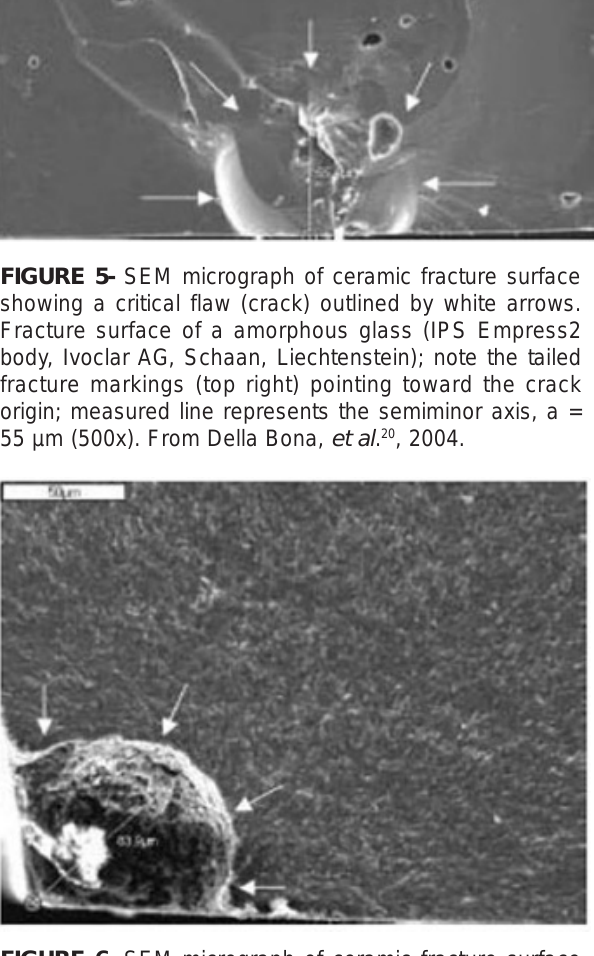
FIGURE 6- SEM micrograph of ceramic fracture surface showing a critical flaw (crack) located at the corner of the specimen (outlined by white arrows). Fracture surface of a leucite-based ceramic (IPS Empress, Ivoclar AG, Schaan, Liechtenstein); line from flaw corner, c = 84 µm (500x). From Della Bona, et al . 20 ,